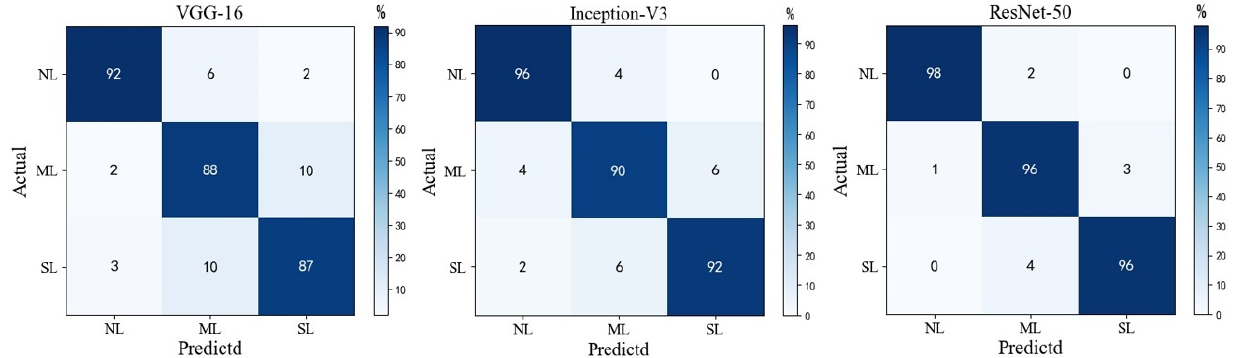
Figure 15. Confusion matrix for the three algorithms through multispectral images. NL is non-lodg-